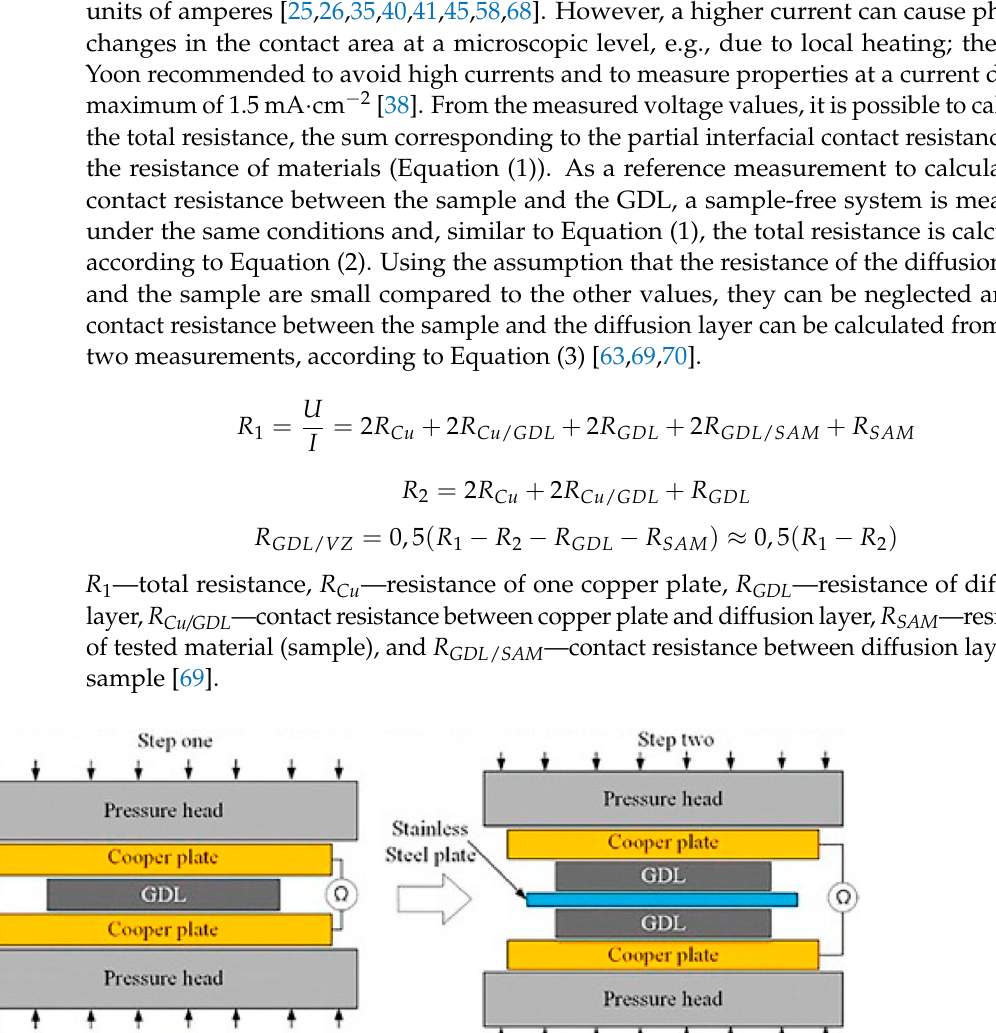
R 1 —total resistance, R Cu —resistance of one copper plate, R GDL —resistance of diffusion layer, R Cu/GDL — contact resistance between copper plate and diffusion layer, R SAM — resistance of tested ma- terial (sample), and R GDL / SAM — contact resistance between diffusion layer and sample [69].